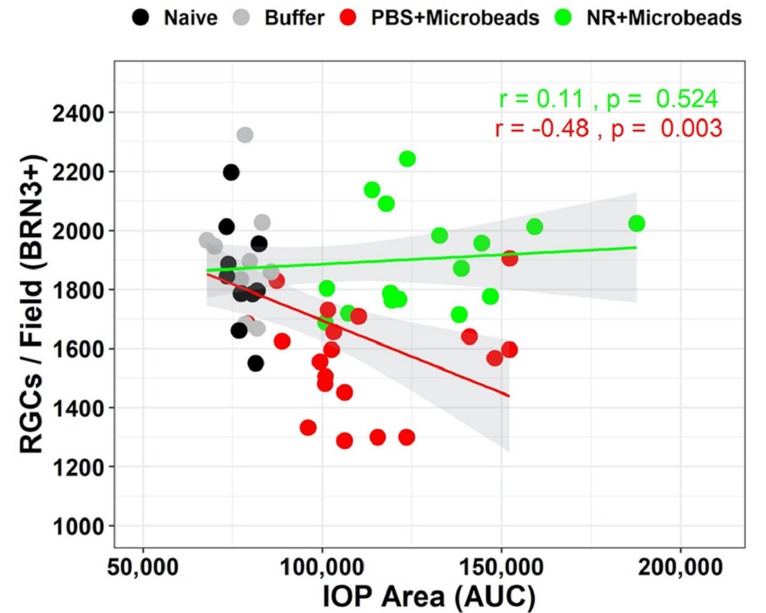
Figure 7. Correlation between Area Under the Curve of IOP changes and RGC survival. The mice in “Naïve” group did not receive microbead injection or any treatment; the mice from “Buffer” group re- ceived buffer (HBSS) injection without any treatment; the mice in “PBS+Microbeads” group received microbead injection and PBS i.p. injection; the mice in “NR+Microbeads” group received microbead injection and NR treatment. In PBS treatment group (red dots), BRN3a+ RGC number was negatively correlated with IOP AUC (r = − 0.48, p = 0.003, Pearson correlation test); while in NR treatment group (green dots), as AUC increasing after microbeads injection, BRN3a+ RGC number did not show correlation (r = 0.11, p = 0.524, Pearson correlation test). A Chow test for differences in regres- sion coefficients indicates the two coefficients are statistically significantly different (F = 11.87337, p = 0.000037). N = 10–19 per